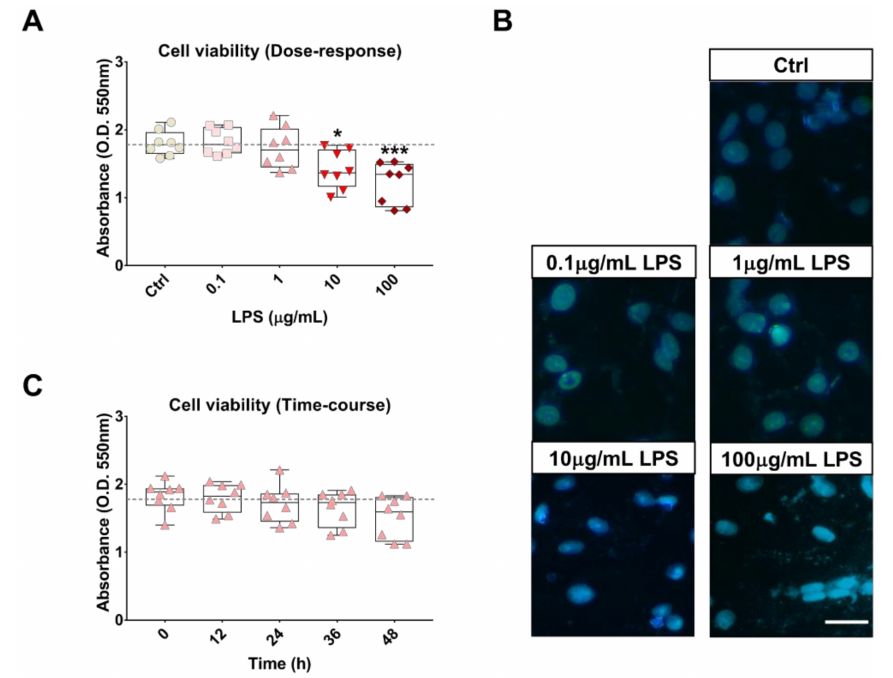
Figure 1. Effects of LPS treatment on RT4 SCs viability. Analysis of cell viability (MTT assay) ( A )